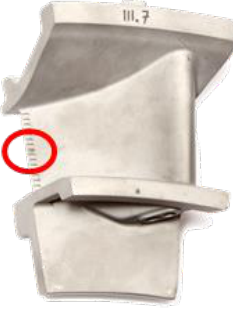
Figure 28. Vane sample (III.7) with eroded defect.